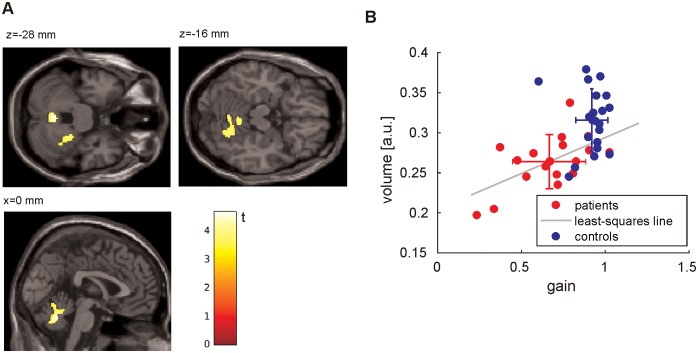
Relation of behavioral parameters to cerebellar grey matter volume changes.Significant (FWE-corrected) gray matter volume reductions in DBN patients (healthy controls > patients) are depicted in cerebellar vermis (lobules VI and VIII and deep cerebellar nuclei) and cerebellar hemispheric lobules (V-VI) in axial and sagittal slices (p<0.001). GMV reduction (ROI of vermal cluster) increases with stronger impairment (gain) of smooth pursuit eye movements (B). Blue (healthy control) and red (patients) circles show individual data, crosses indicate the mean of gain and ROI-based volume ± standard deviation.